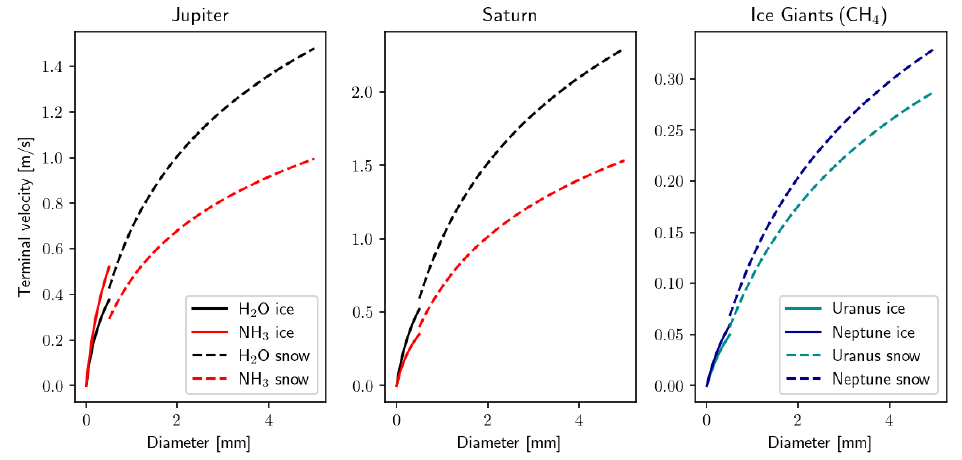
Figure 9. Typical terminal velocity profiles of different species on Solar System gas giant atmospheres. The first two panels show the terminal velocity of water (black) and ammonia (red) ice and snow, on Jupiter and Saturn respectively at a pressure of 5 bars. The third panel shows the terminal velocity of methane ice on Uranus (light blue) and Neptune (dark blue). The solid lines correspond to cloud ice particles, and the dashed lines corresponds to